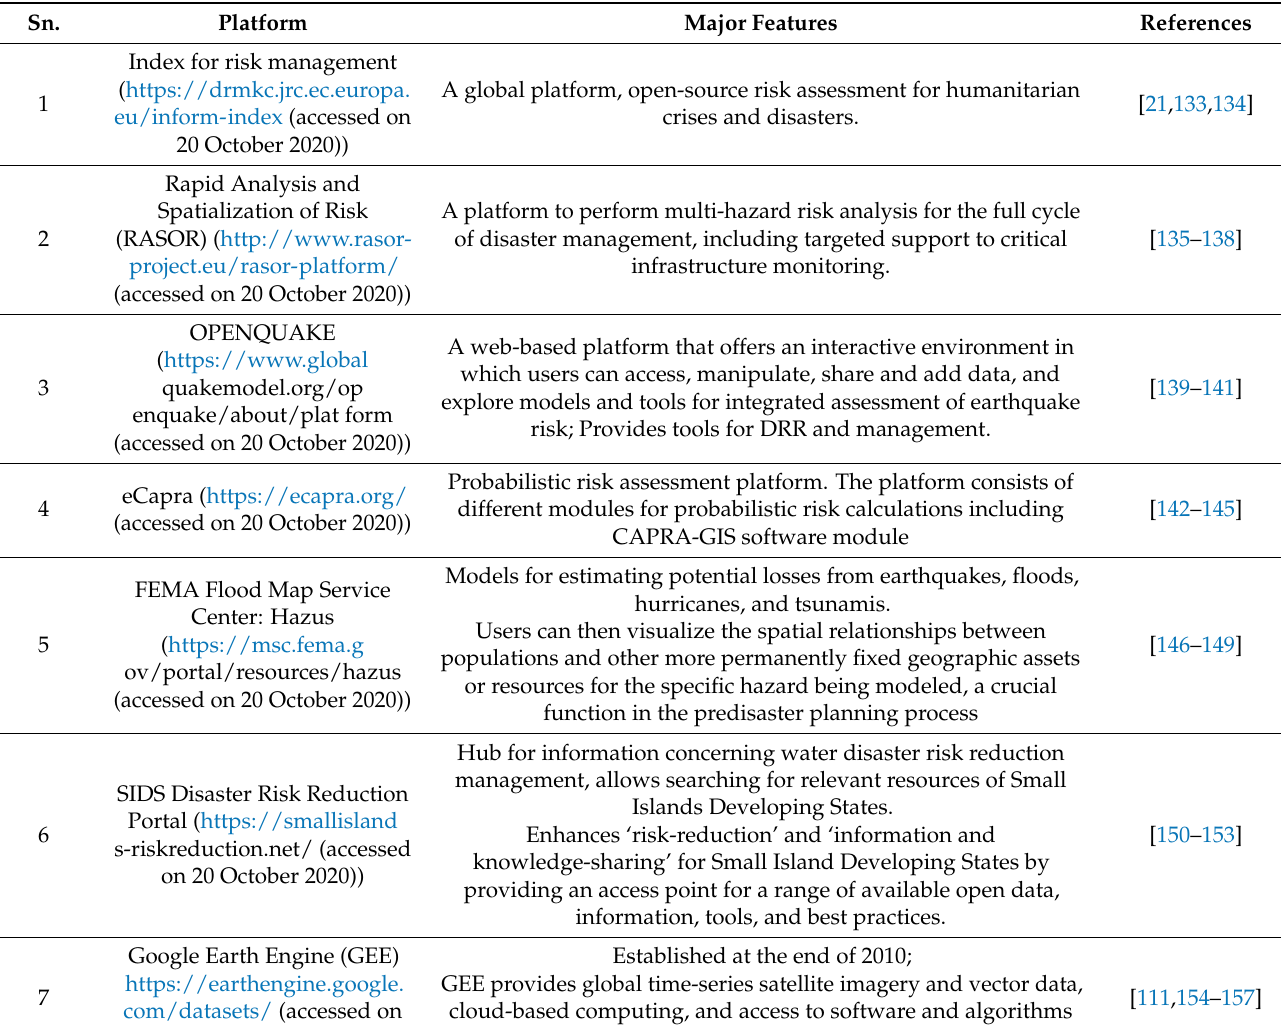
Table 6. Open-source online platform for the flood risk